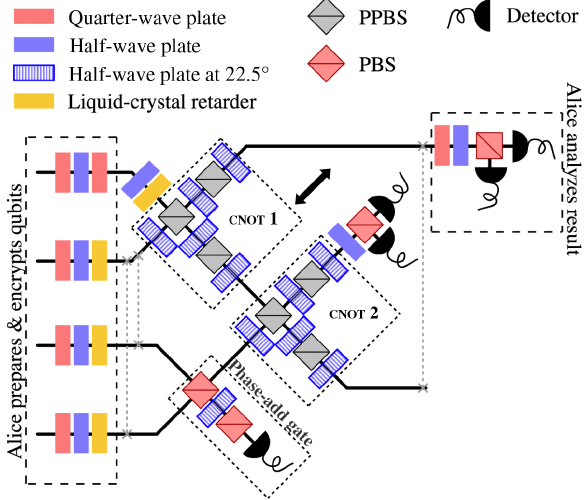
FIG. 6. Schematic of optical circuit designed to implement each canonical case enumerated in Fig. 2. Each incoming rail from the left is a separate photon from a SPDC event (see Fig. 7 for source schematic). Liquid-crystal retarders allow us to modulate the phase of a qubit much more quickly and precisely than a motorized wave plate mount. Two-qubit gates shown here in dashed boxes can be bypassed as necessary, either by swapping a photon onto another rail (gray dashed lines) or by translating “ CNOT 1 ” out of the optical